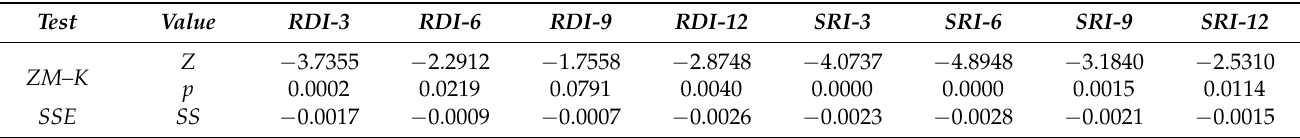
Table 1. Z-values of the M–K test ( ZM–K ) and Sen’s slope estimator ( SSE ) of the RDI and SRI series during 1984–2015 (values in bold represent statistically significant trends at a 5% significance level).